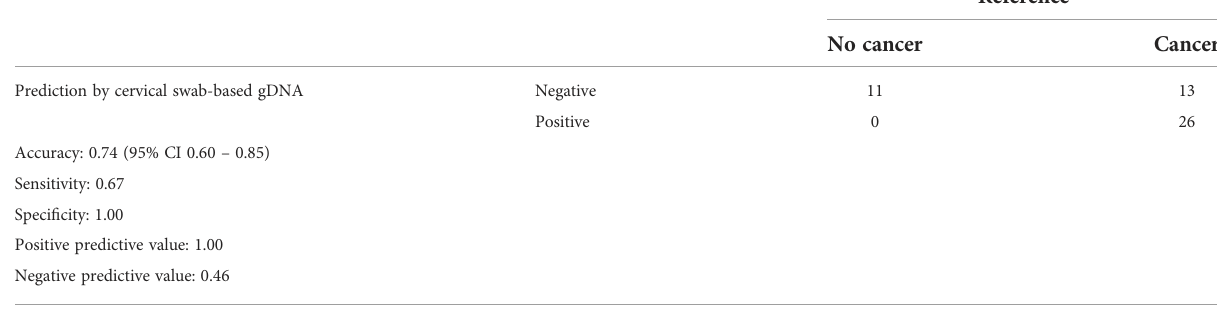
TABLE 2 Performance of cervical swab-based genomic DNA (gDNA) for predicting endometrial cancer versus benign uterine